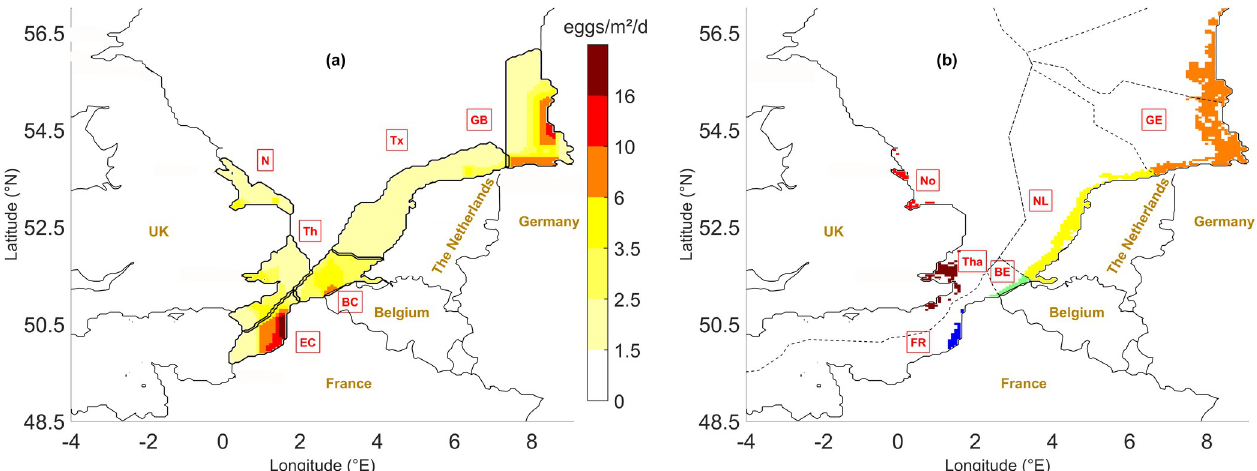
Fig 3. Geographic implementation of the L ARVAE &C O model. (a) Distribution of the main spawning grounds of Solea solea in the wider North Sea (European Economic Communities delineated by black lines) with contour plots of the mean daily egg production (redrawn from ICES-FishMap [38]. Eggs are released at six known spawning grounds: Off the Belgian coast (BC), off Texel (Tx), the inner German Bight (GB), the eastern English Channel off the French coast (EC), off the mouth of the Thames River (Th) and on the Norfolk Banks (N). (b) Six nursery grounds located in shallow muddy to sandy coastal areas < 20 m depth, subdivided according to national boundaries (FR, BE, NL, GE) except for the United Kingdom, where a southern (Tha) and northern (No) nursery area were distinguished. Each colour represents the spatial extent of each nursery. The dotted black lines represent the national Exclusive Economic Zones of the different countries. Adapted maps redrawn with permission from Lacroix et al. [13].